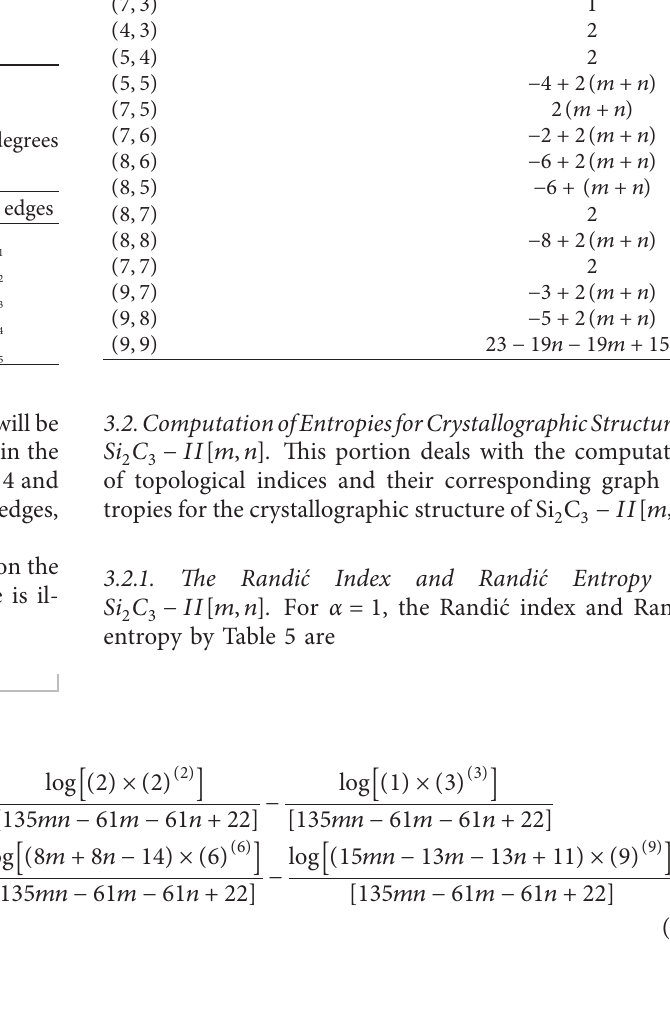
Table 4: Vertex partition of Si of each vertex.